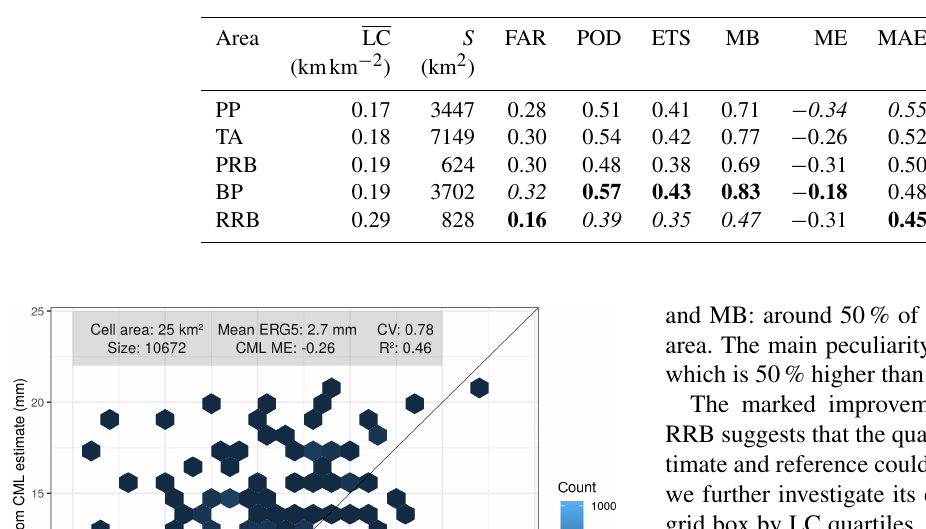
Table 3. Statistical indicators for each considered area, considering the highest-resolution information (grid box scale), shown in ascending order of LC. Continuous indicators are normalized and fractional. Values in bold (italics) are the best (worst) values in the column.